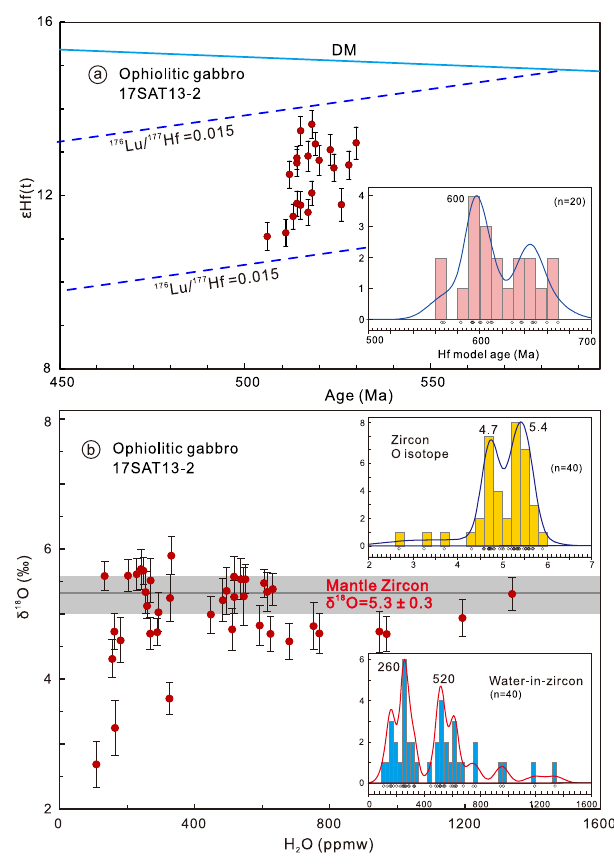
Fig. 3 Zircon Hf-O isotopes and water contents of the ophiolitic gabbro. a Hf isotopes. b δ 18 O vs. H 2 O content for zircons from 17SAT13-2. Error bars are 2